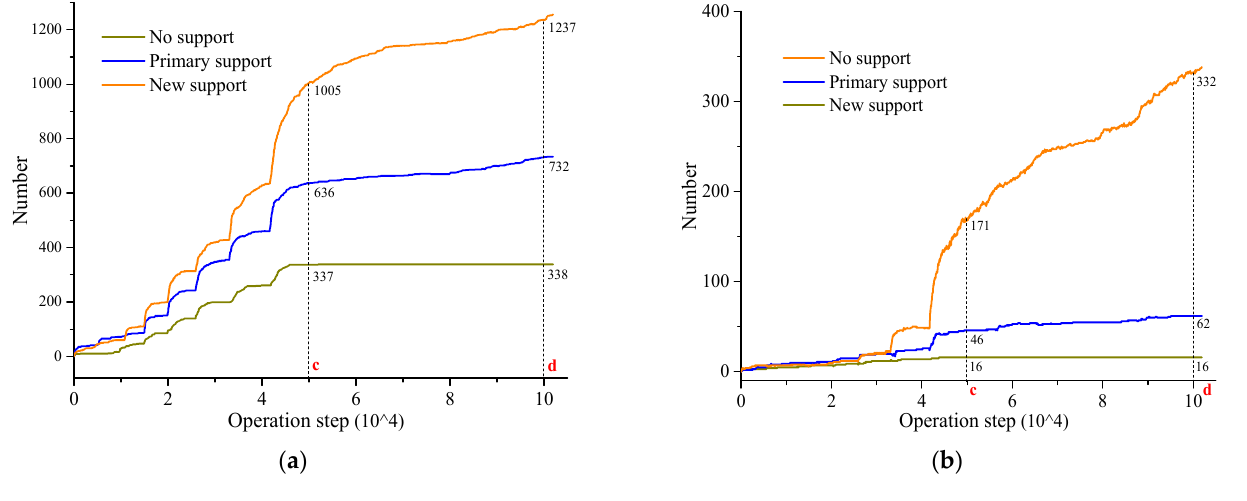
Figure 19. Evolution curves of cracks in Zone A of the roadway under different support forms. ( a ) Shear crack; ( b ) tension crack.